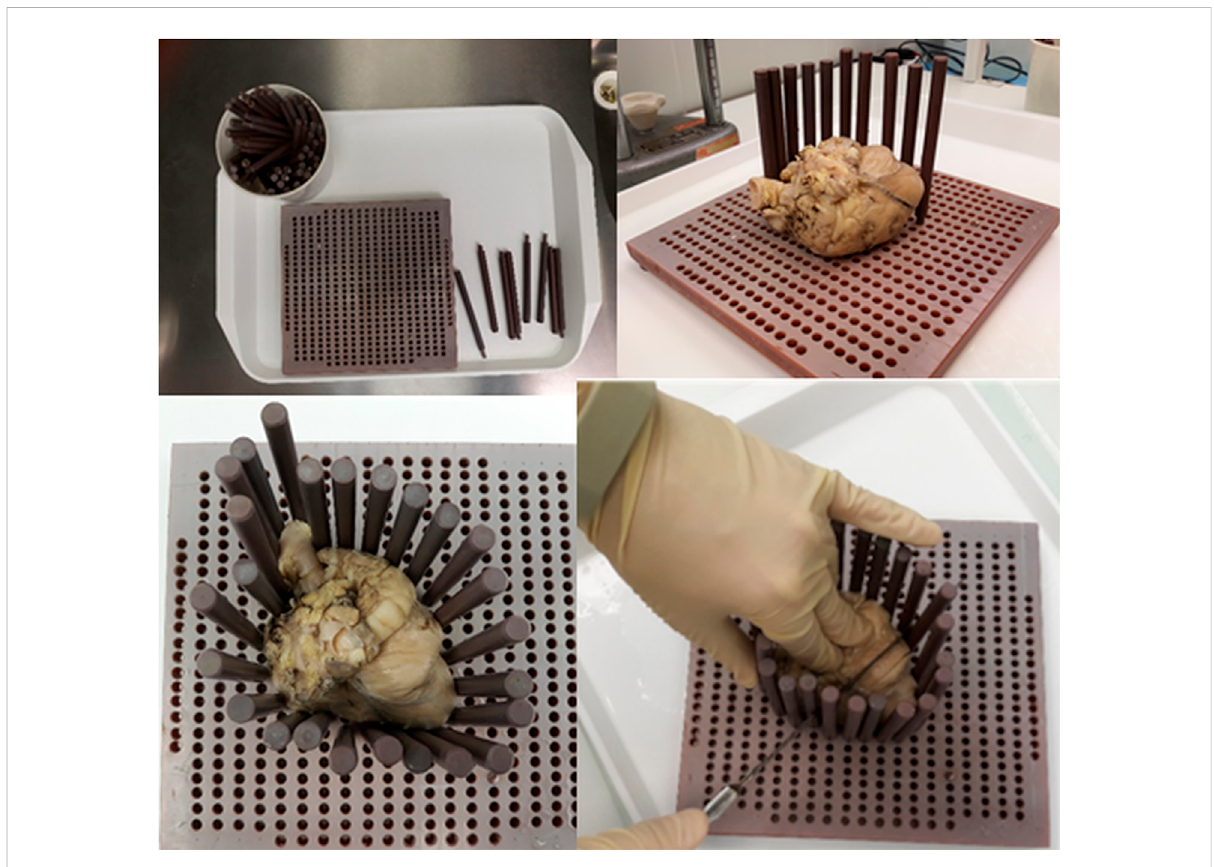
FIGURE 4 Use of the macrotome for slicing of the ventricles. In the basic plate are holes arranged in parallel rows. The swine heart is placed on the macrotome plate and fi xed by pins all the way round. The heart is gradually sliced using a long sharp knife.